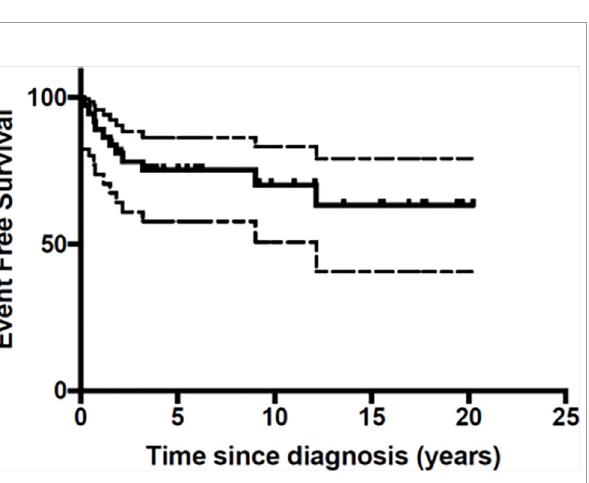
FIGURE 1 | Event Free Survival (EFS) of the 37 patients with malignant melanoma.